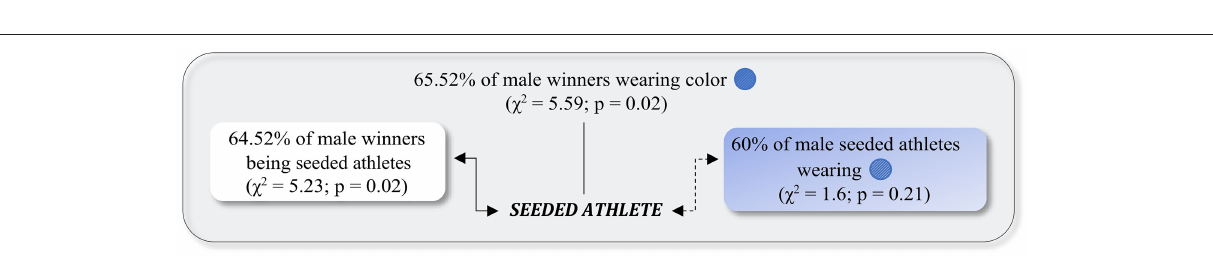
FIGURE 2 | Relationship between the color of the protectors and the result of the match, considering seeded athletes as a moderation factor, for male athletes in heavyweight, Rome 2018 World Grand Prix Series 1. Continuous lines indicate significant relationships. Discontinuous lines indicate non-significant